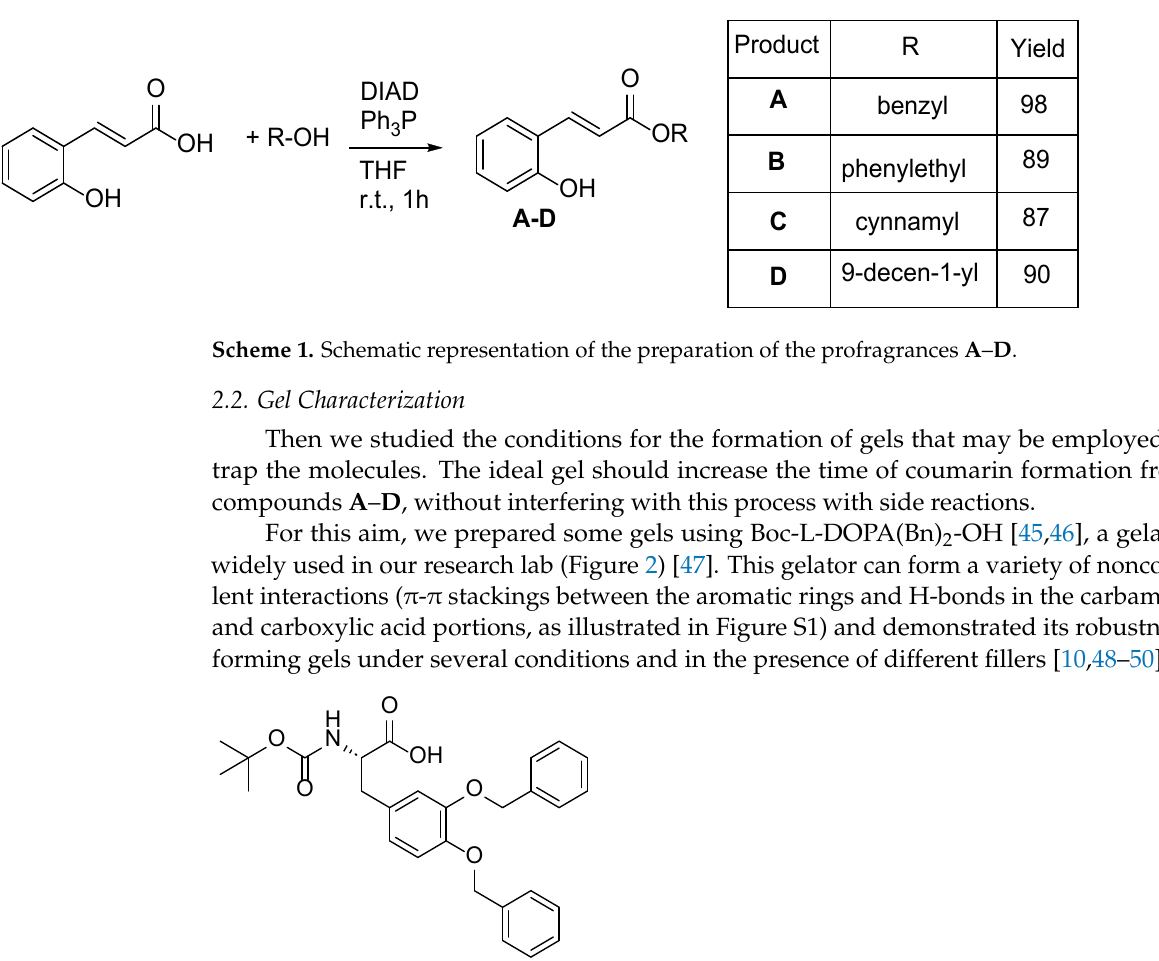
Figure 2. Chemical structure of the gelator Boc-L-DOPA(Bn) 2 -OH.